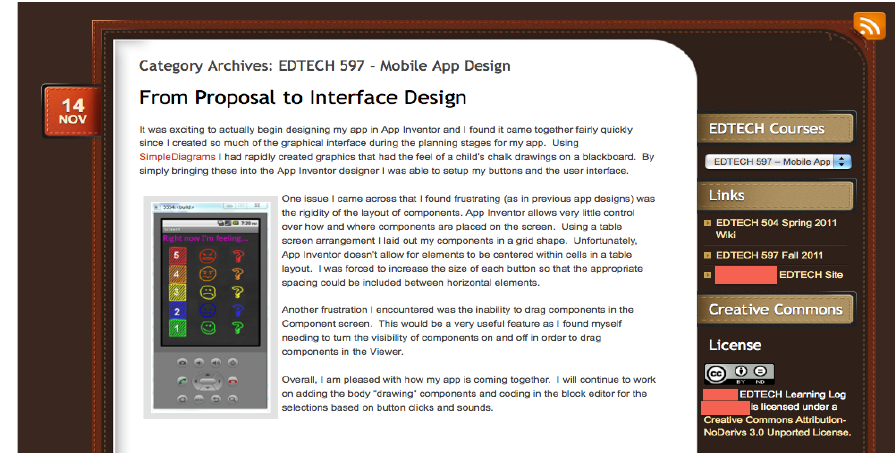
Figure 5. An example of app design